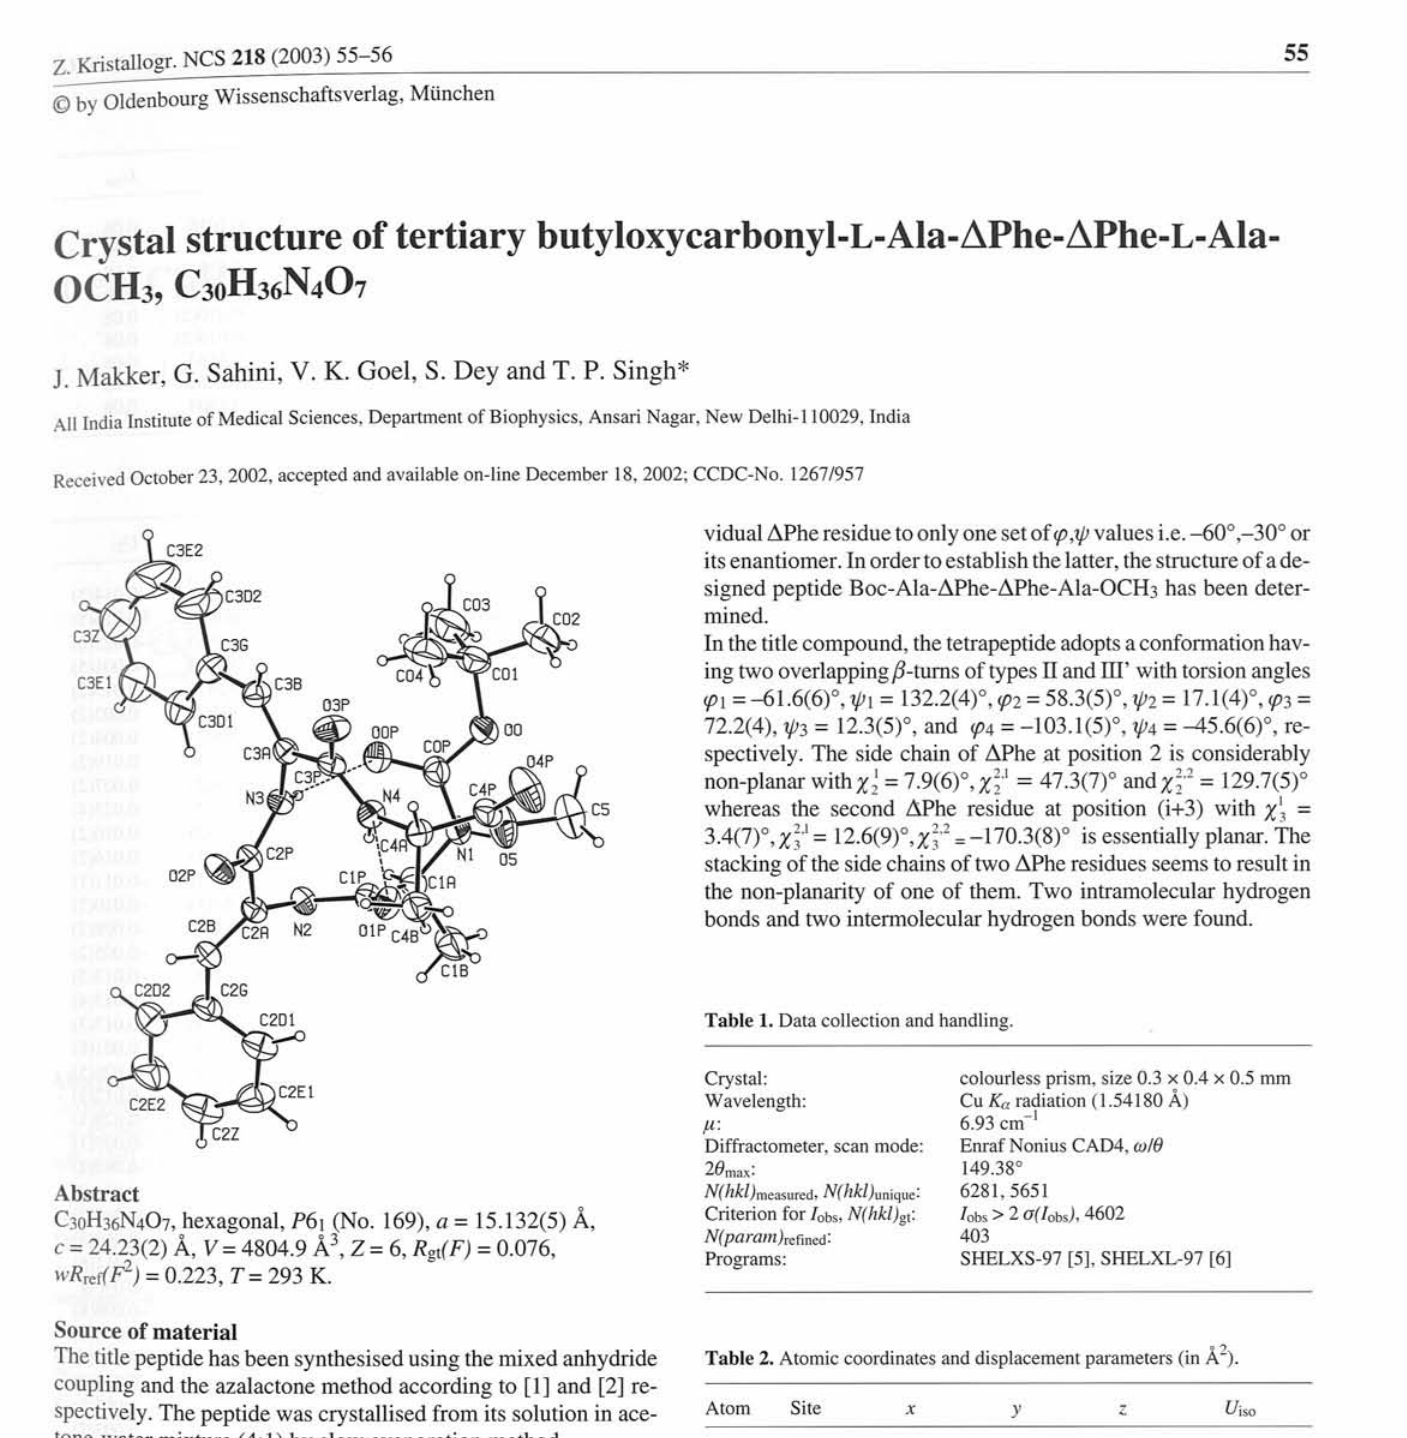
Table 2. Atomic coordinates and displacement parameters (in